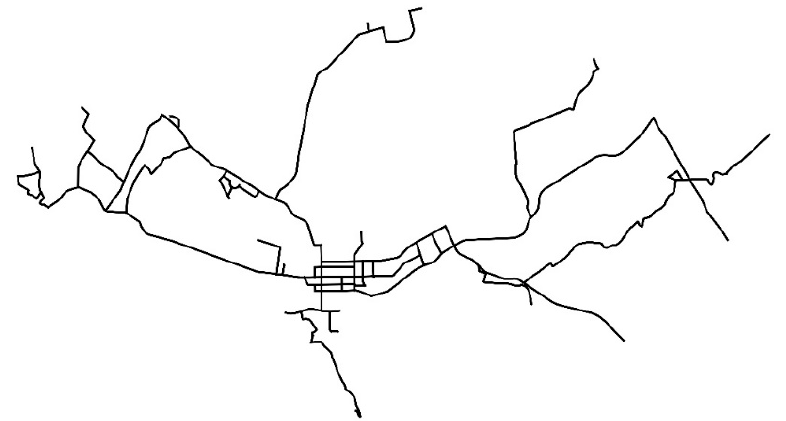
Figure 8. Schematic diagram of Qitaihe public transportation vehicle operation network.